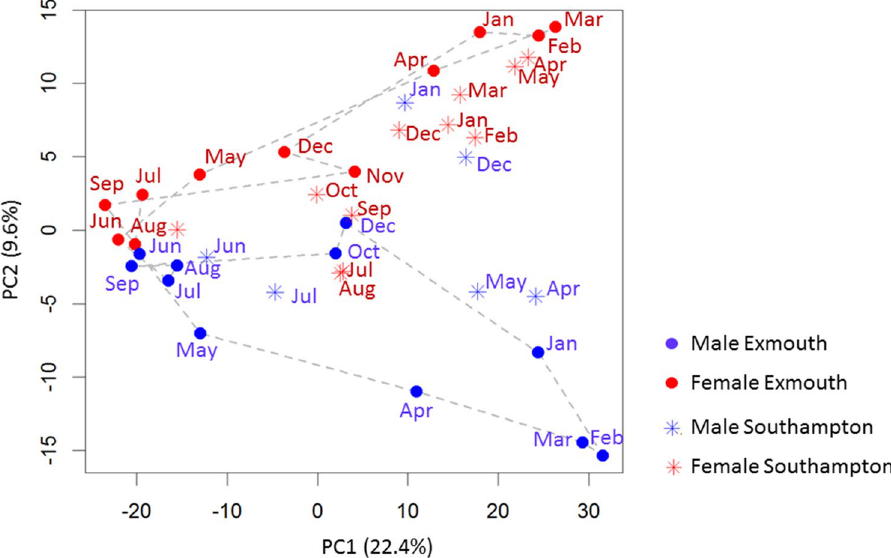
Figure 2. Principal component analysis (PCA) of cluster medians in both sex and sites during the annual cycle. Red represents females and blue males, solid dots are Exmouth (reference site) mussel medians, stars are Southampton